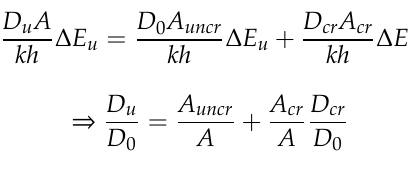
Figure 2. Partition hypothesis of resistance for the upper part with crack.